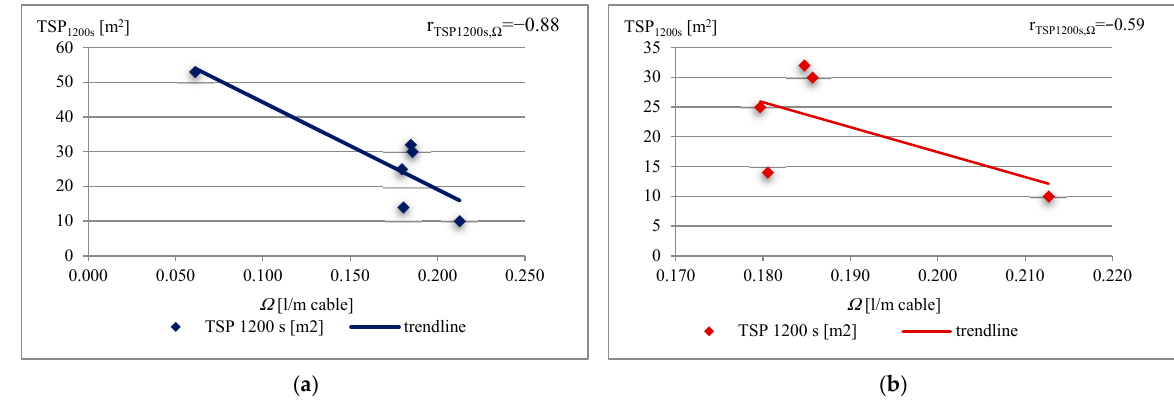
Ω for the tested 1200s and